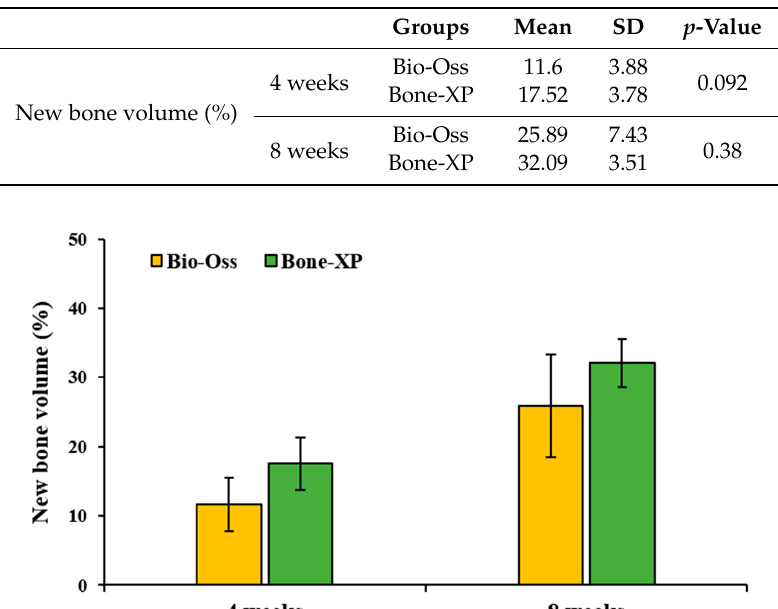
Table 2. New bone volume within area of interest (AOI). (n = 5).